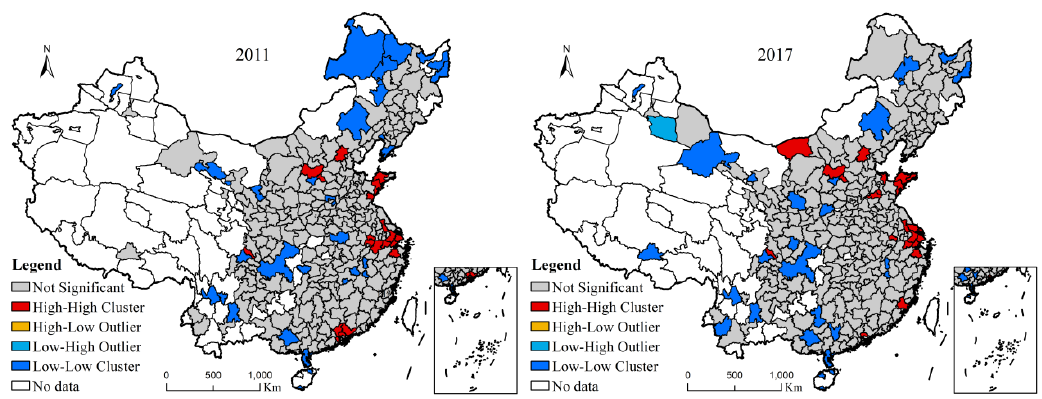
Figure 4. LISA bivariate spatial correlations between green technology efficiency and innovation capability in the manufacturing industry.